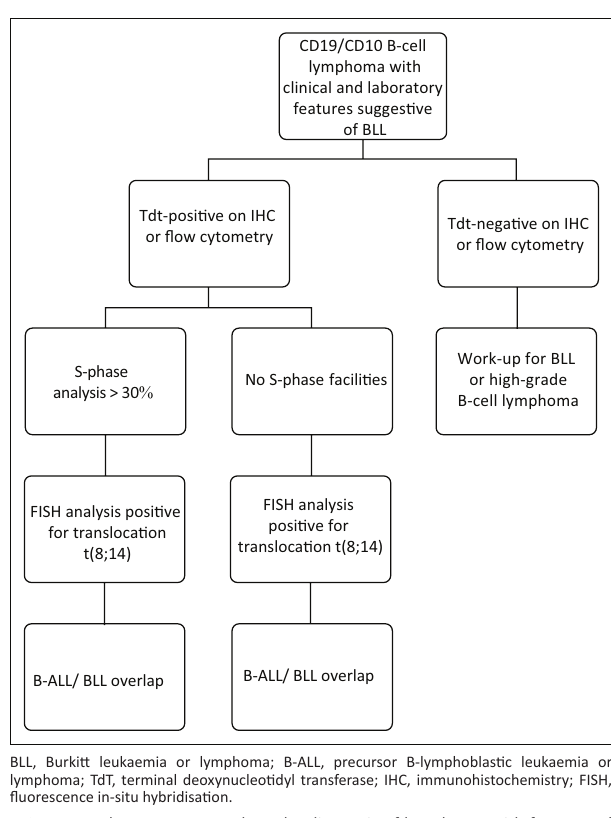
FIGURE 4: Laboratory approach to the diagnosis of lymphoma with features of precursor B-lymphoblastic leukaemia or lymphoma and Burkitt leukaemia or lymphoma.